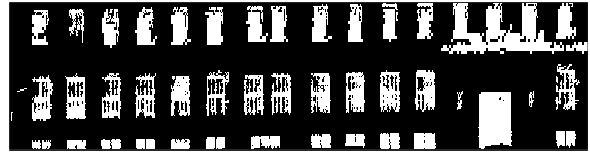
Figure 10. the union of two images (in figure 8 and figure 9) in search areas